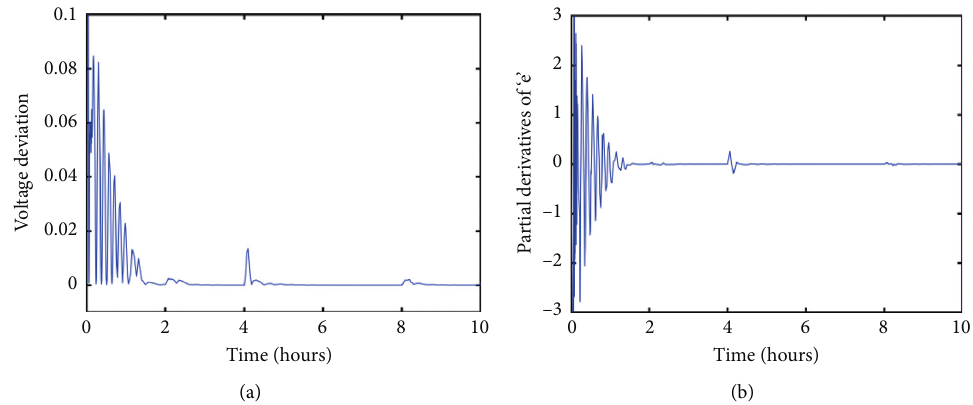
Figure 5: Reference input for fuzzy systems: (a) magnitude of deviation and (b) the first derivative of the magnitude of the Figure 4. The switching frequency of the control input directly affects the control effect of the system.